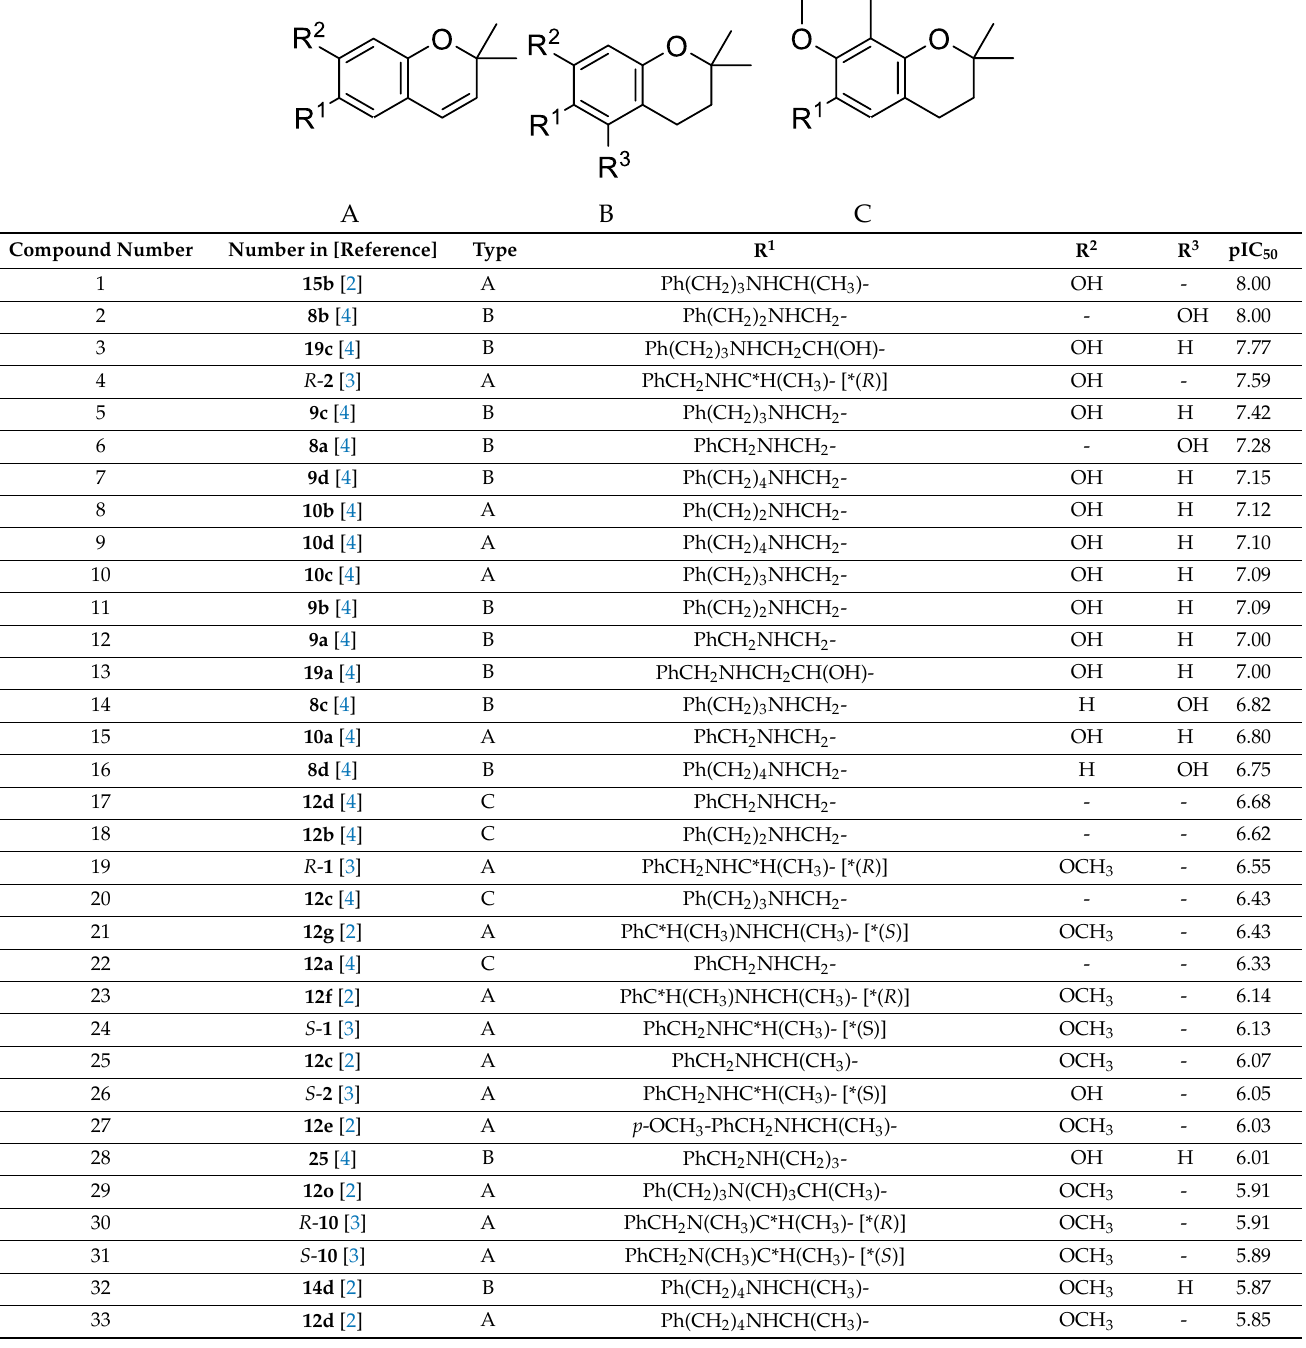
Molecules 2021 , 26 , x FOR PEER REVIEW tested for antiprotozoal activity up to the present. Several of these compounds have demon- strated impressive in vitro antiplasmodial activity at half-maximal inhibitory concentration the internal predictions during LOO-CV ( Q 2 ) as well as for test set predictions ( P 2 )). The (IC 50 ) values in the nanomolar range, accompanied by high selective toxicity towards the results are shown in Table 2. parasites in comparison with mammalian cells [2–4]. Table 1. Structures and activity against Plasmodium falciparum (pIC 50 ) values of the compounds under study. Note that the compounds are tabulated and numbered in the order of decreasing activity. Unless otherwise stated, the C- 1′ ( R )-enantiomer was used in case of compounds with a chiral center at this position (see the Materials and Methods section).